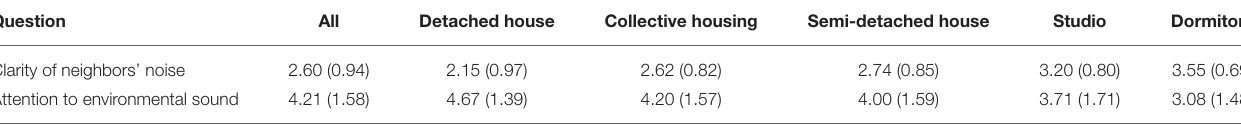
TABLE 13 | Housing type and environmental sounds. Question All Detached house Clarity of neighbors’ noise Attention to environmental sound